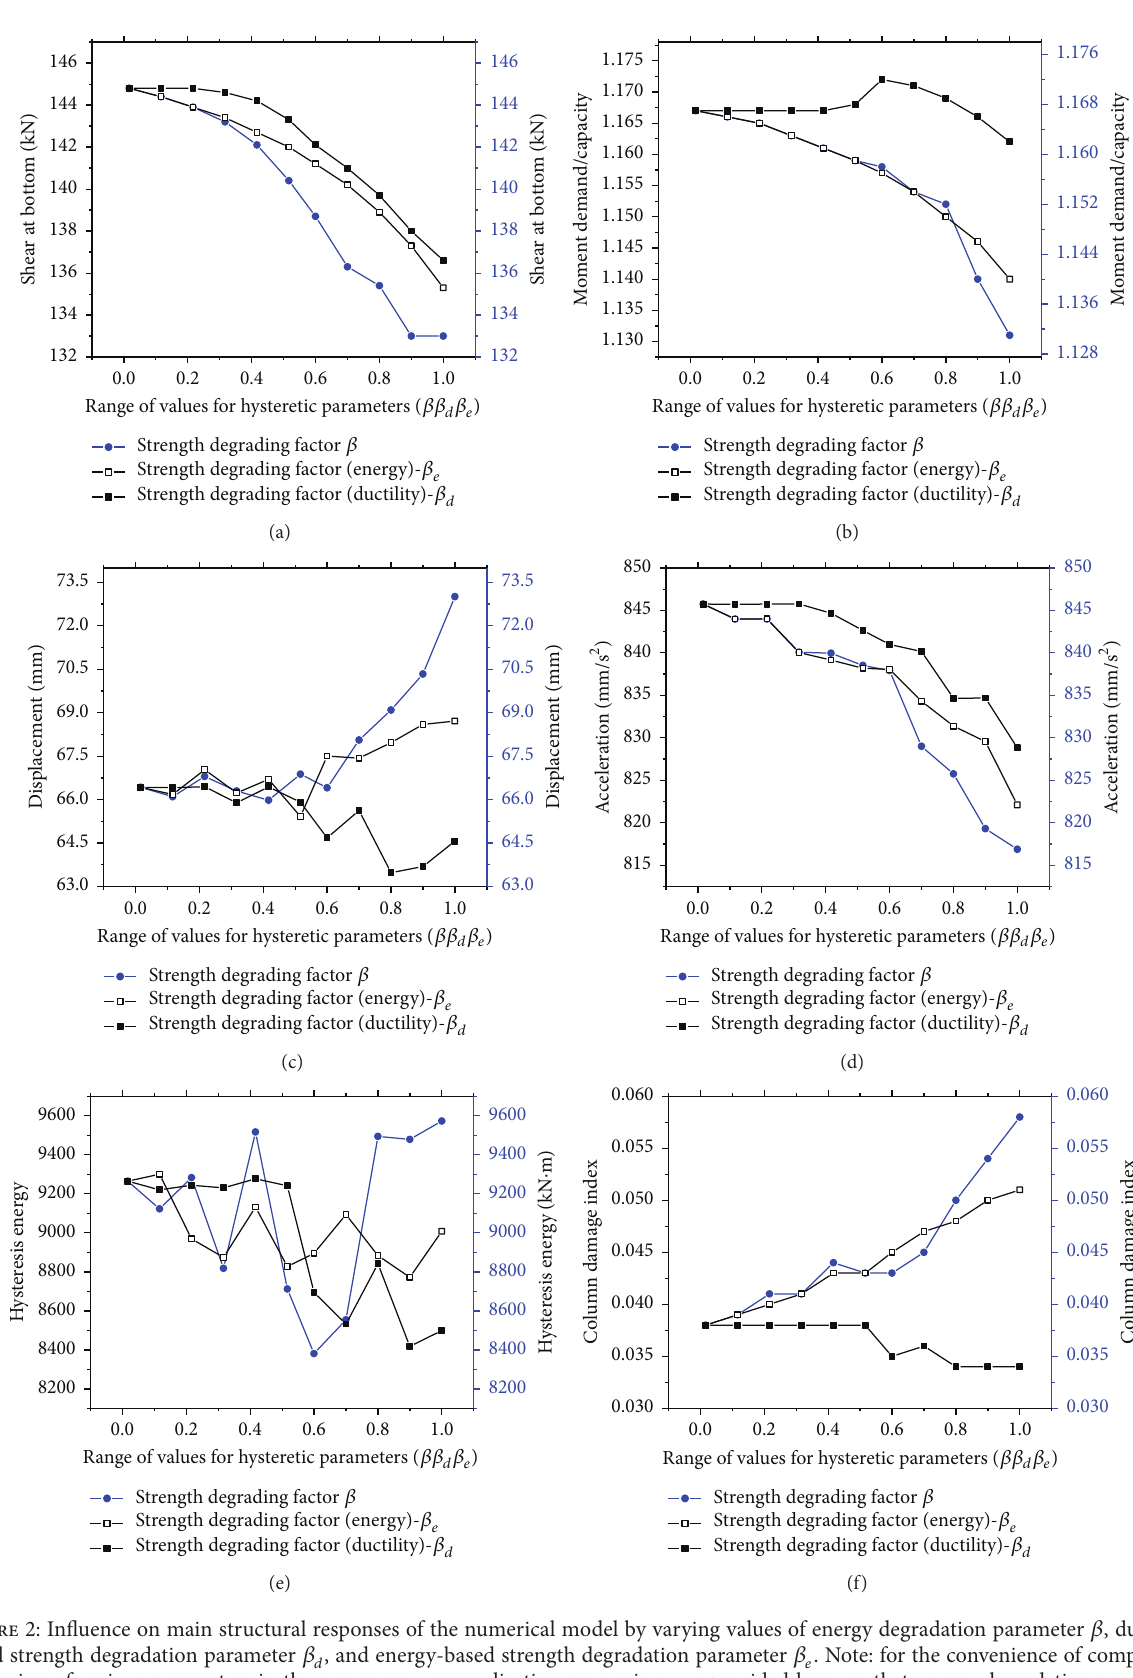
Figure 2: Influence on main structural responses of the numerical model by varying values of energy degradation parameter 𝛽 , ductility- based strength degradation parameter 𝛽 𝑑 , and energy-based strength degradation parameter 𝛽 𝑒 . Note: for the convenience of comparative expression of various parameters in the same range, normalization processing was provided here, so that energy degradation parameters 𝛽 ∈ (0.0, 1.0) 𝛽𝛽 𝑑 𝑒